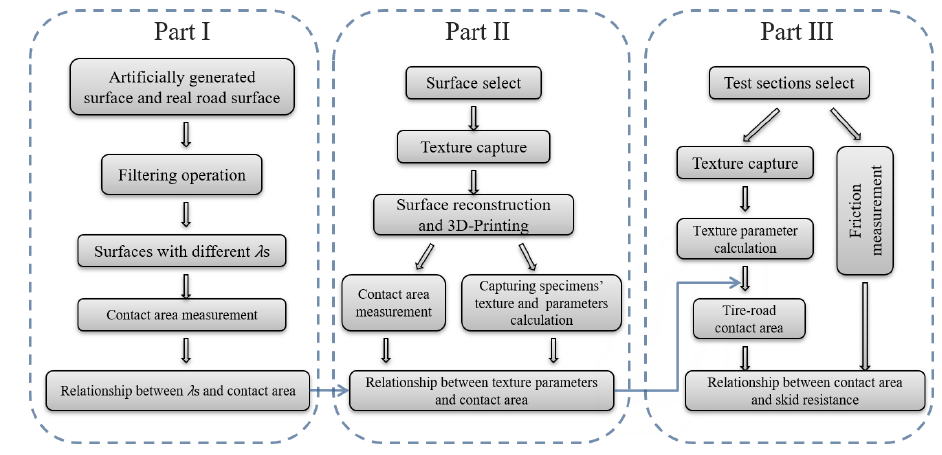
Figure 1. Experimental procedure of this study.